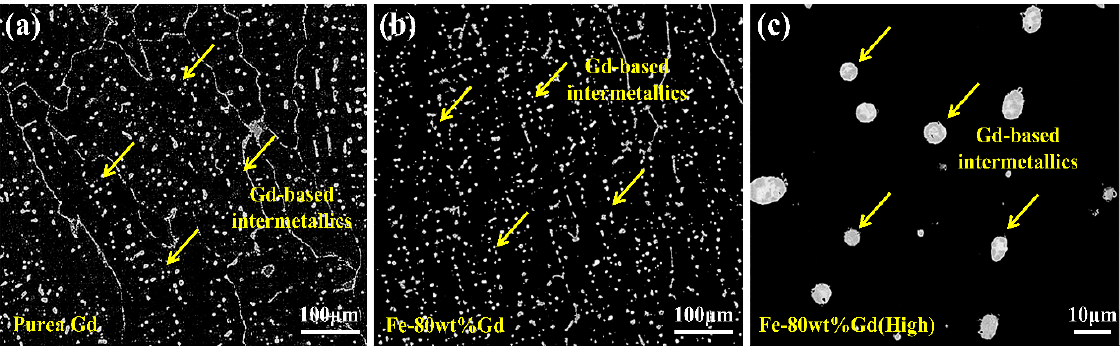
Figure 7. BSE images of 1 wt% Gd/2205DSS stainless steel alloy by ( a ) pure Gd, ( b ) Fe–80 wt% Gd, and ( c ) the high magnification of Gd-based intermetallic compounds [37].